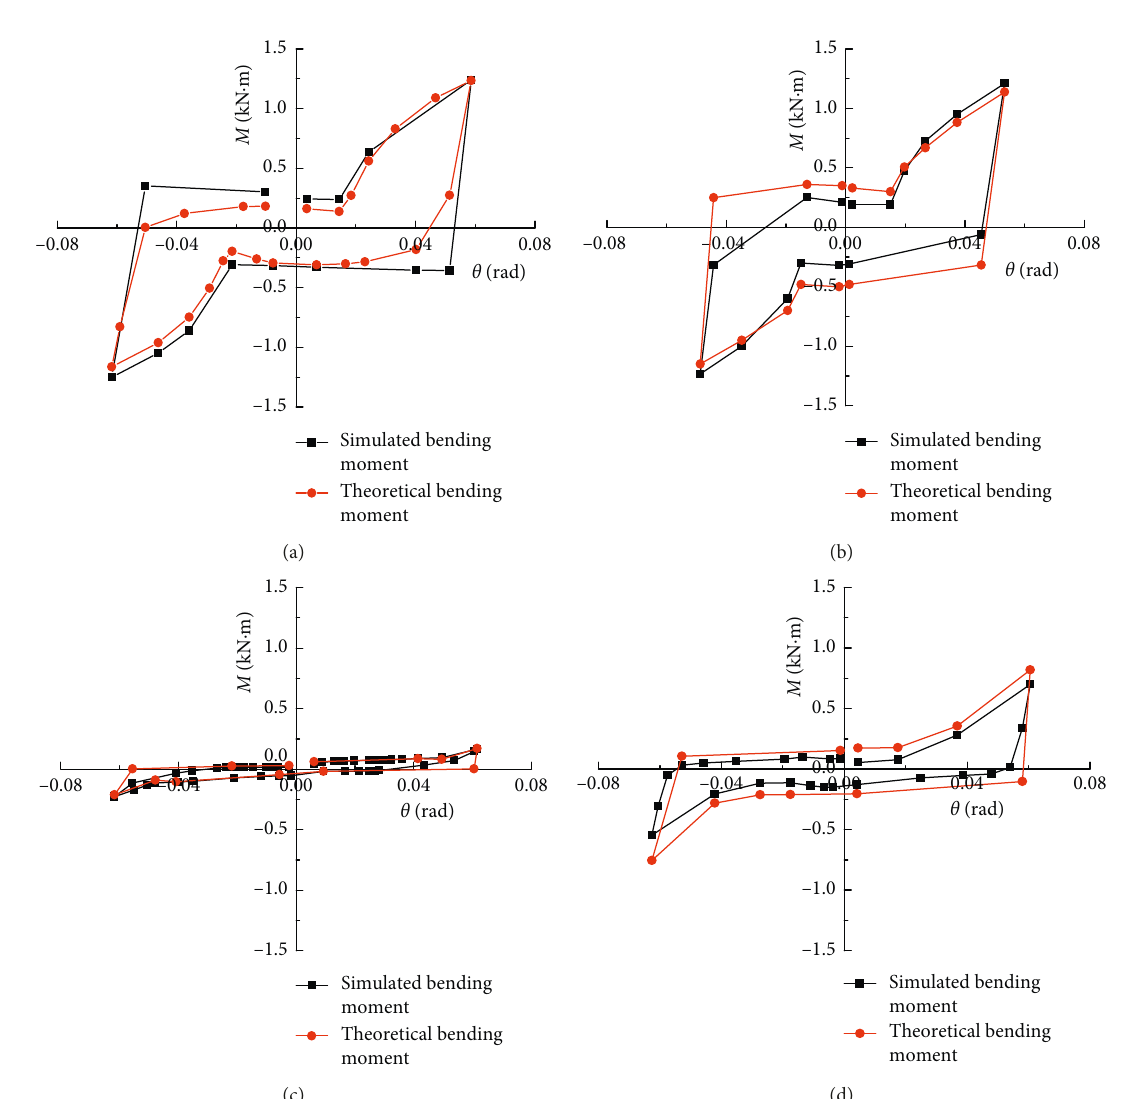
Figure 13: Comparison of bending moments from the proposed theoretical calculation and the simulation. (a) No damaged joint, (b) pulling damaged joint, (c) contraction damaged joint, and (d) mixed damage greater than the friction between the mortise-tenon, the surfaces of the mortise, so there is only a small friction tenon will slide, and when the rotation angle reaches at force between the upper and lower surfaces and the 0.06 rad, the tenon slides into the deeper part of the bottom of the mortise. When the axial force in the strut is